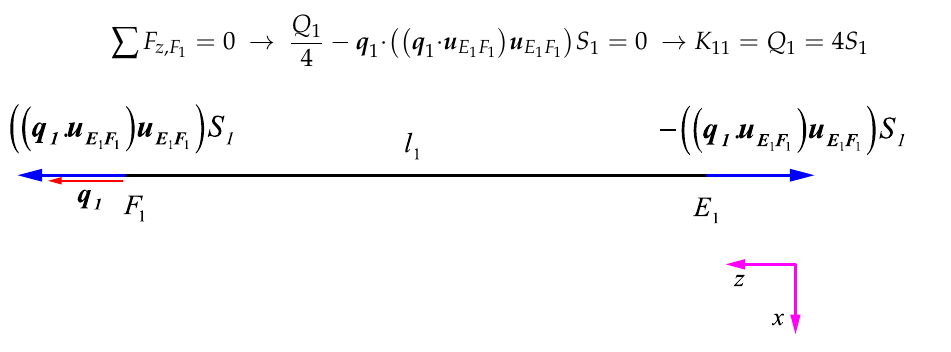
Figure 6. Deformation of strut EF due to 𝑞 (cid:2869) = 1 .